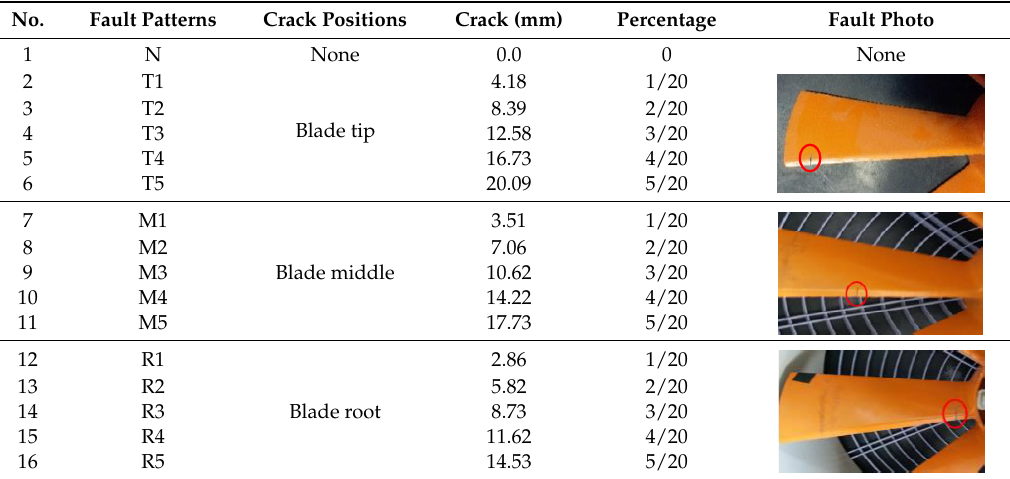
Figure 10. Test rig. ( a ) Major structure; ( b ) Auxiliary structure. Table 5. Fault pattern of the rotating blades.